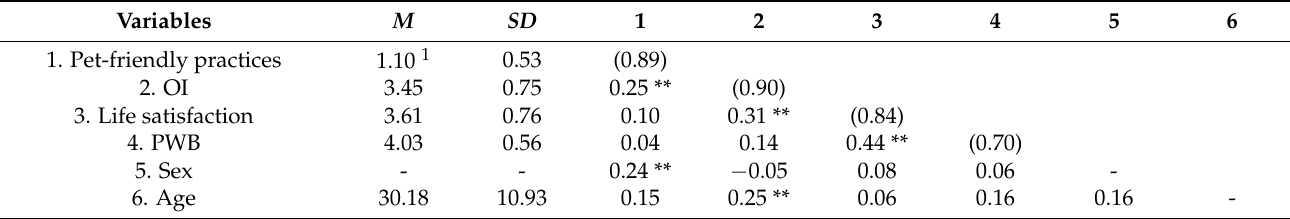
Table 1. Correlations and descriptive statistics of the